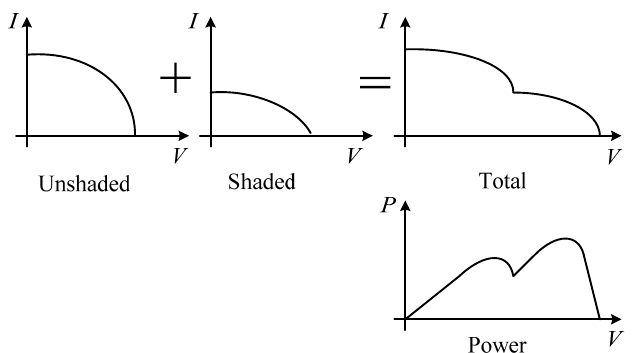
Figure 3. Illustrating the impact of shading on two PV modules connected in series [17].